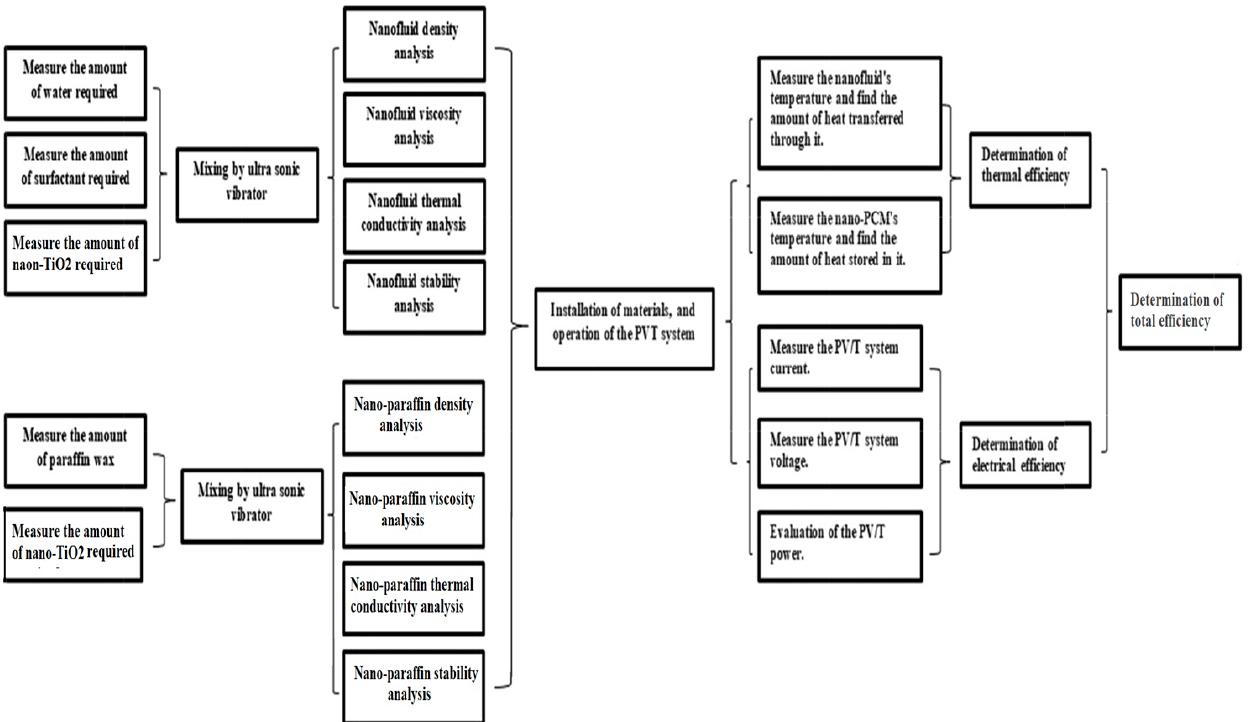
Figure 1. Block diagram for practical steps conducted in the study.